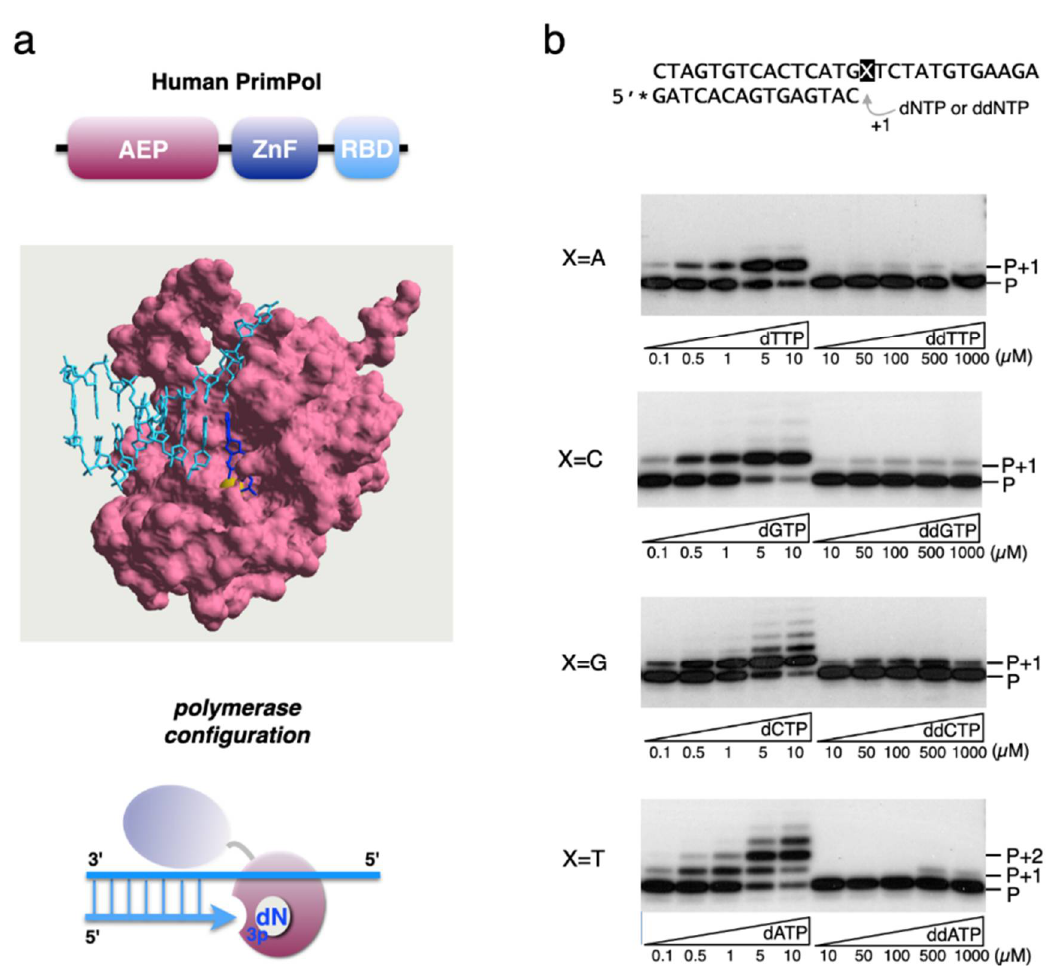
Figure 1. ddNTPs are not efficiently inserted during DNA polymerization by PrimPol. ( a ) Top: Schematic representation of the three domains of eukaryotic PrimPols: AEP (pink), Zn-finger domain (blue), and RPA-binding domain (cyan); centre: molecular surface representation of human PrimPol AEP core in pink (lacking the C-terminal region including the Zn-finger and RPA domains) forming a ternary complex with a DNA template/primer substrate (cyan), the incoming nucleotide (blue), and the metal cofactor (Ca 2+ in yellow) were created with Swiss-PdbViewer (PDB id: 5L2X [18]); bottom: Schematics of PrimPol in polymerase configuration where the catalytic core (in pink) binds the 3′end of the primer (arrow in cyan) and the incoming deoxynucleotide triphosphate (in blue). C-terminal domain of PrimPol (in purple) does not collaborate in the binding. ( b ) PrimPol (200 nM) incorporation of individual dNTPs (0.1, 0.5, 1, 5 and 10 µM) or the equivalent ddNTP (10, 50, 100, 500 and 1000 µM) opposite each complementary template base (2.5 nM), and using Mn 2+ as metal cofactor. P indicates the position of the 5′-labeled primer (indicated as *) that can be extended by one or more nucleotides (P + 1, P + 2...).